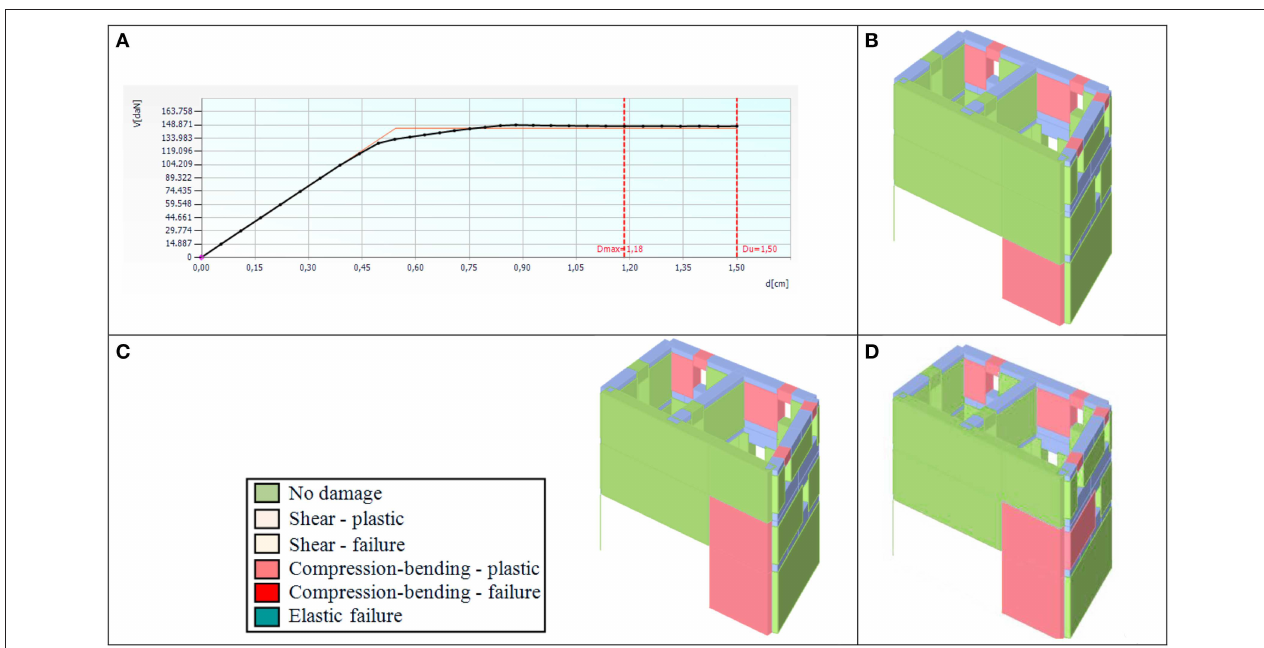
FIGURE 10 | Seismic behavior in direction X of the isolated S.U. type C: MDOF pushover curve (A) and damage patterns related to the conventional yielding limit (B) , maximum base shear (C) , and ultimate displacement D u (D) .